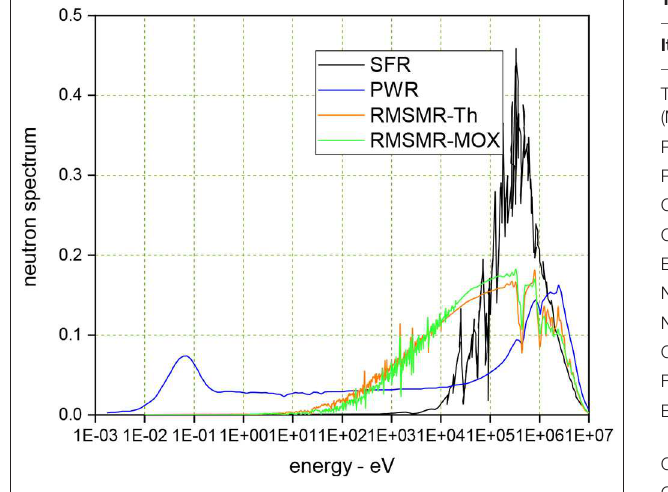
FIGURE 5 | Neutron spectrum comparisons.